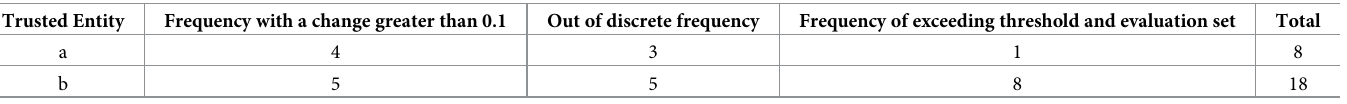
Trusted Entity Frequency with a change greater than 0.1 Out of discrete frequency Frequency of exceeding threshold and evaluation set